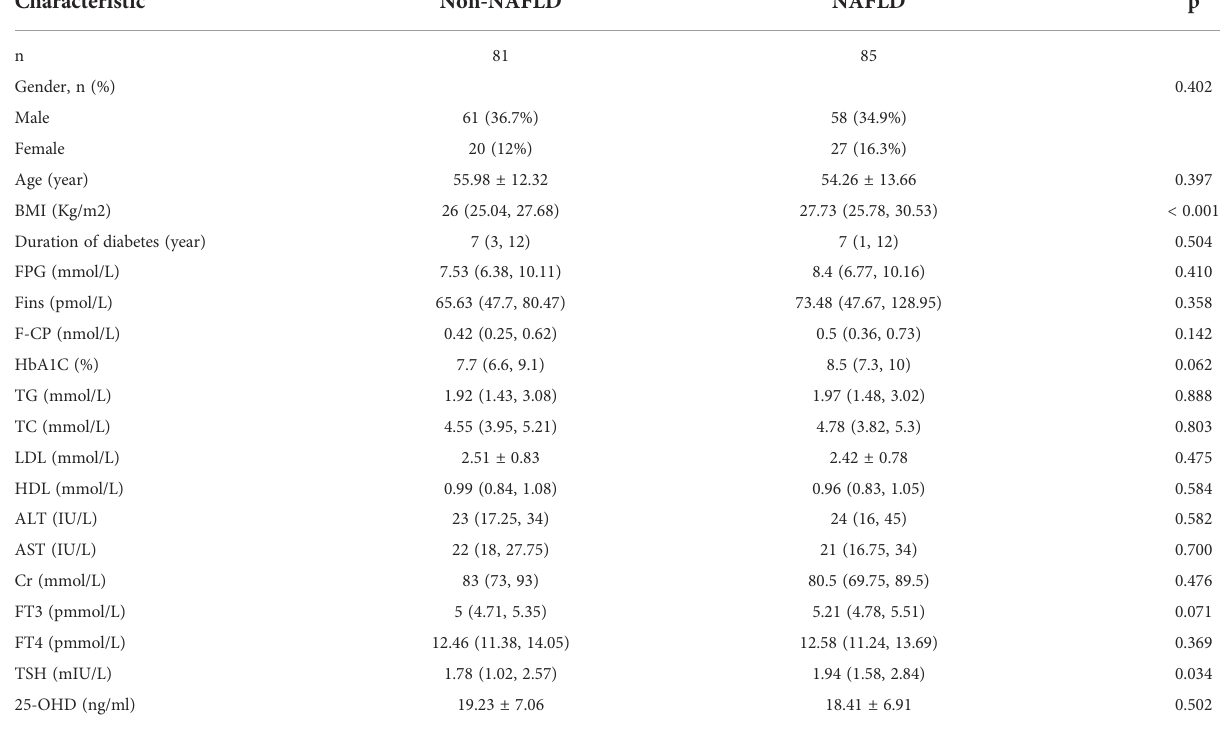
TABLE 1 Demographic and metabolism characterization of study